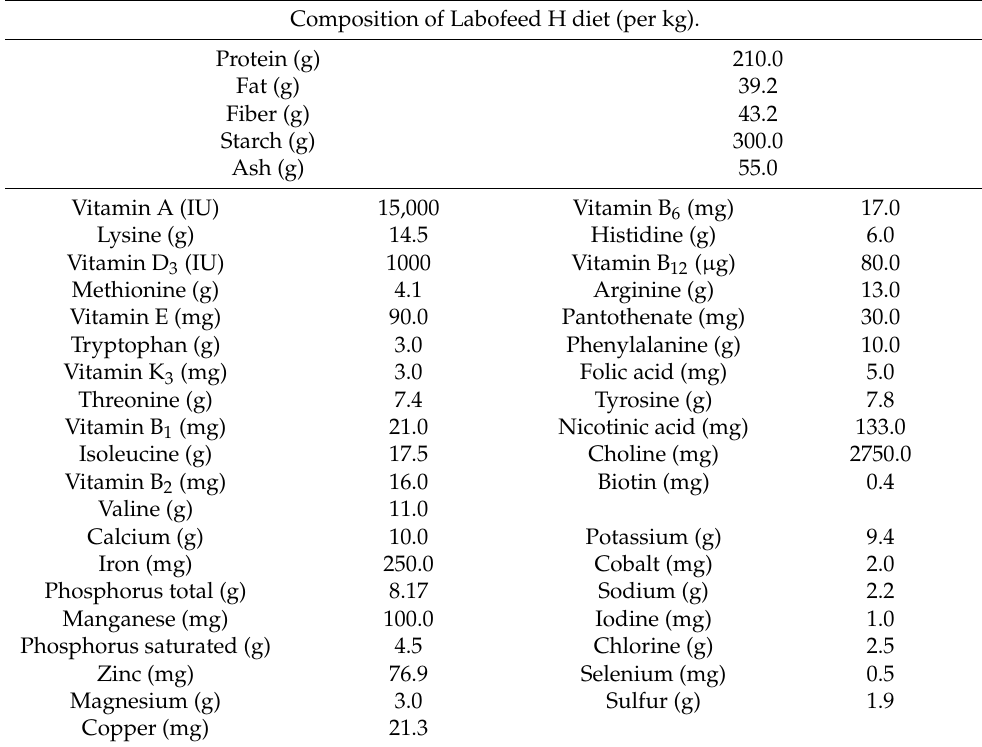
Table 1. Labofeed H—composition (per kg of